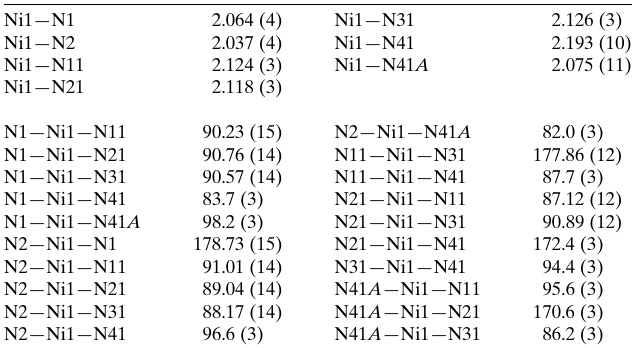
Table 1 Selected geometric parameters (A˚ , (cid:4) ).